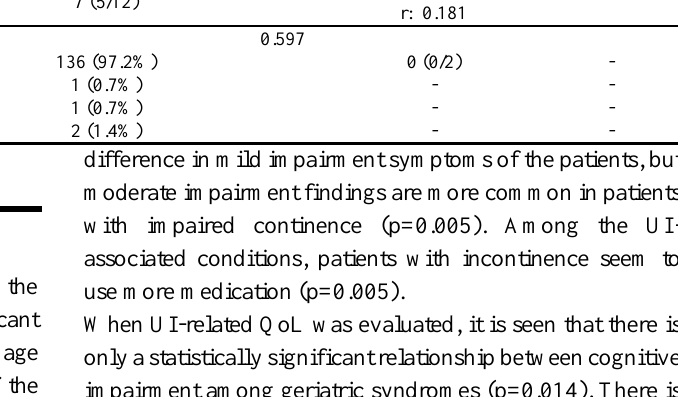
Table 4: The relationship of urinary incontinence (UI) with geriatric syndromes and related factors. Geriatric syndromes and related